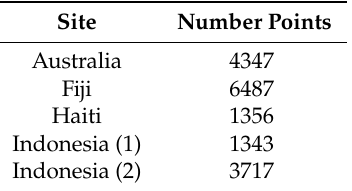
Table 2. Regions where the accuracy assessment was undertaken and the number of accuracy samples which were